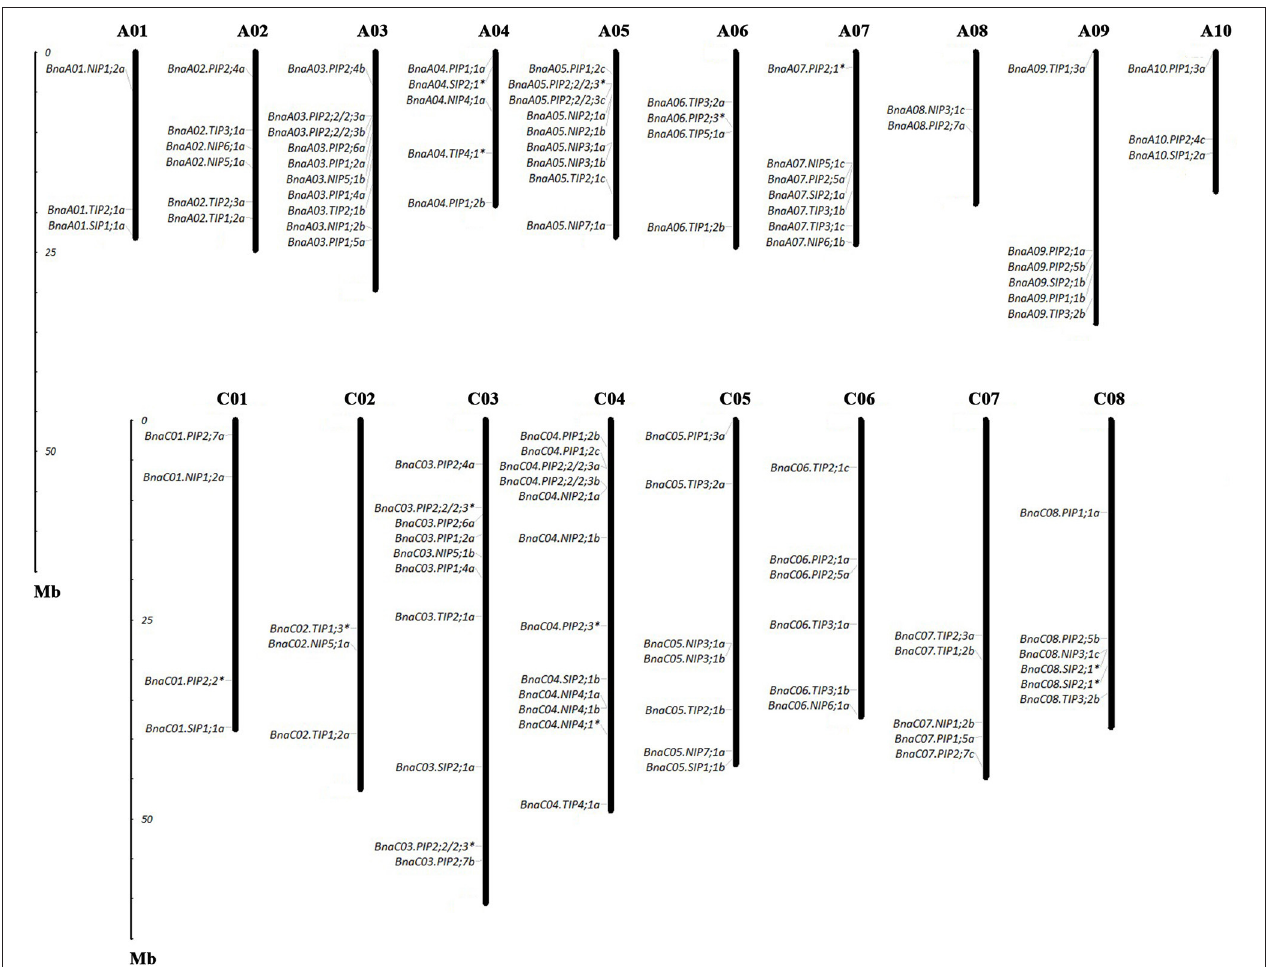
FIGURE 2 | Chromosomal location of AQPs in Brassica napus . The gene chromosome location diagram was drawn using the MapInspect software. There were 95 full-length and 13 incomplete BnaAQP s located on 18 chromosomes. The genes marked with asterisk (*) represented the incomplete BnaAQP s.